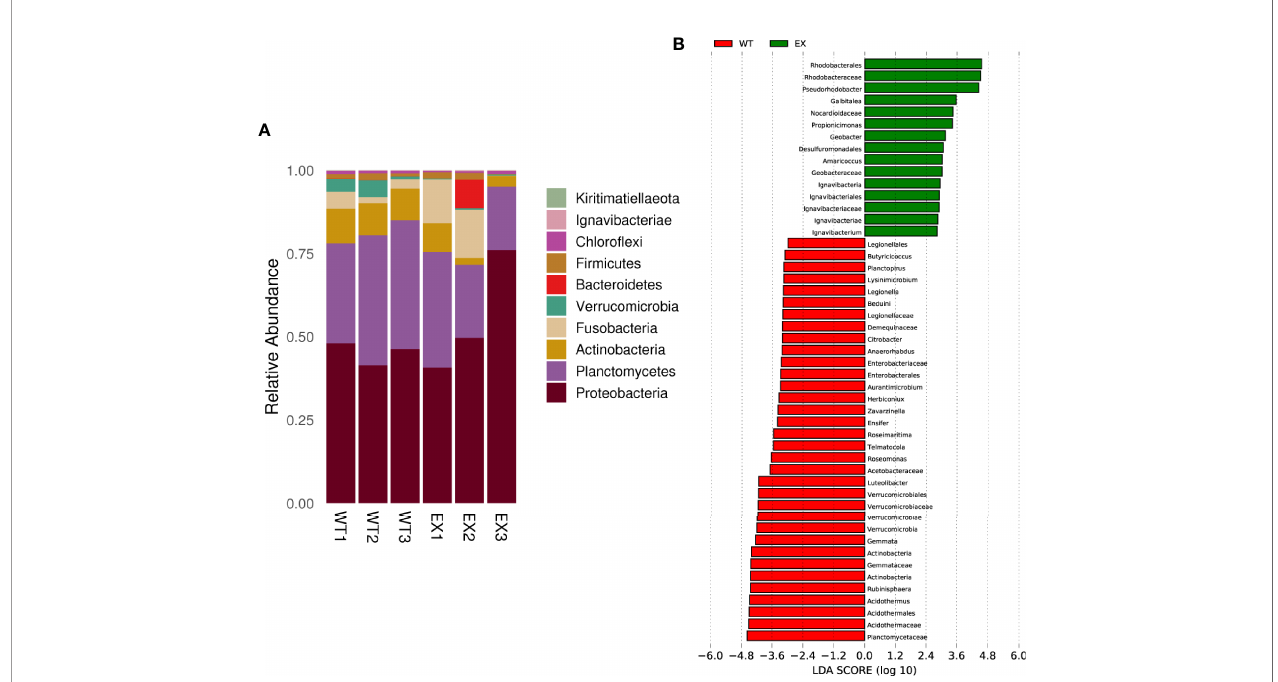
FIGURE 7 | Effects of BaX030 on the intestinal fl ora of grass carp. (A) The composition of bacterial community on total 6 samples at phylum level; (B) Effect of BaX030 on the intestinal microbiome of grass carp by LefSe